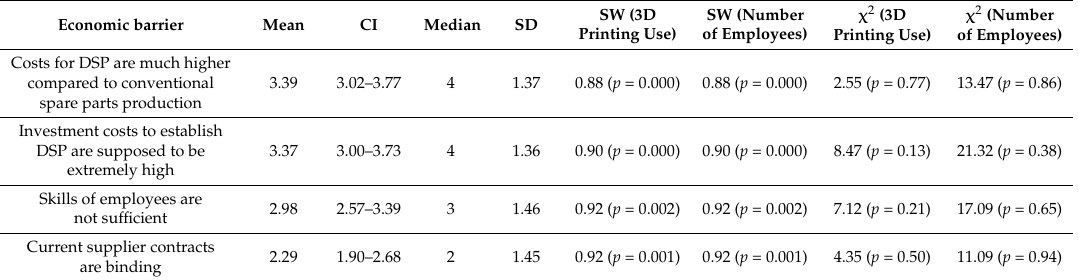
Table 5. Ranked economic barriers of DSP, N = 50; CI = confidence interval, SD = standard deviation, SW = Shapiro Wilk, χ 2 = Chi-squared